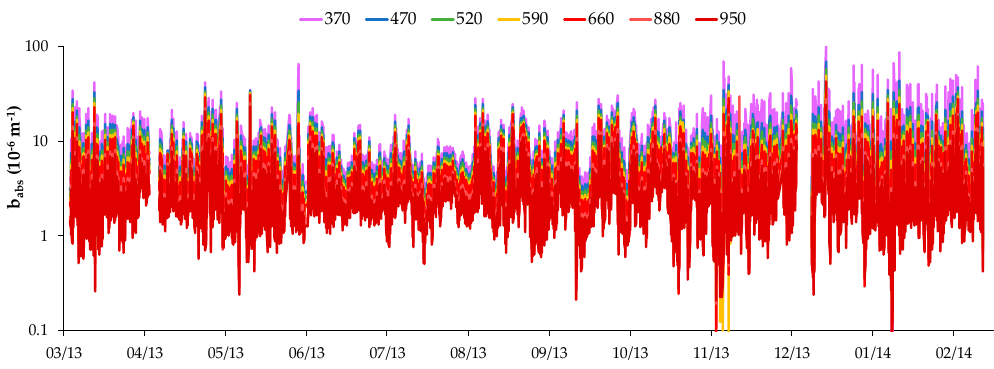
Figure 1. Absorption coefficients ( b abs ) at seven wavelengths measured at Demokritos (DEM) stations during 2013–2014.